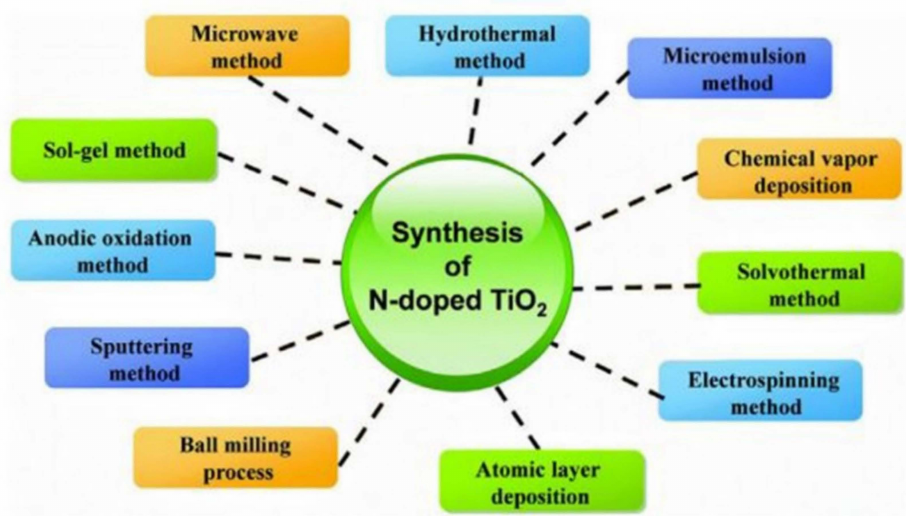
Figure 17. Different methods that are suitable to prepare nitrogen-doped TiO 2 . Reprinted with permission from Elsevier, 19 December 2021 Ref.